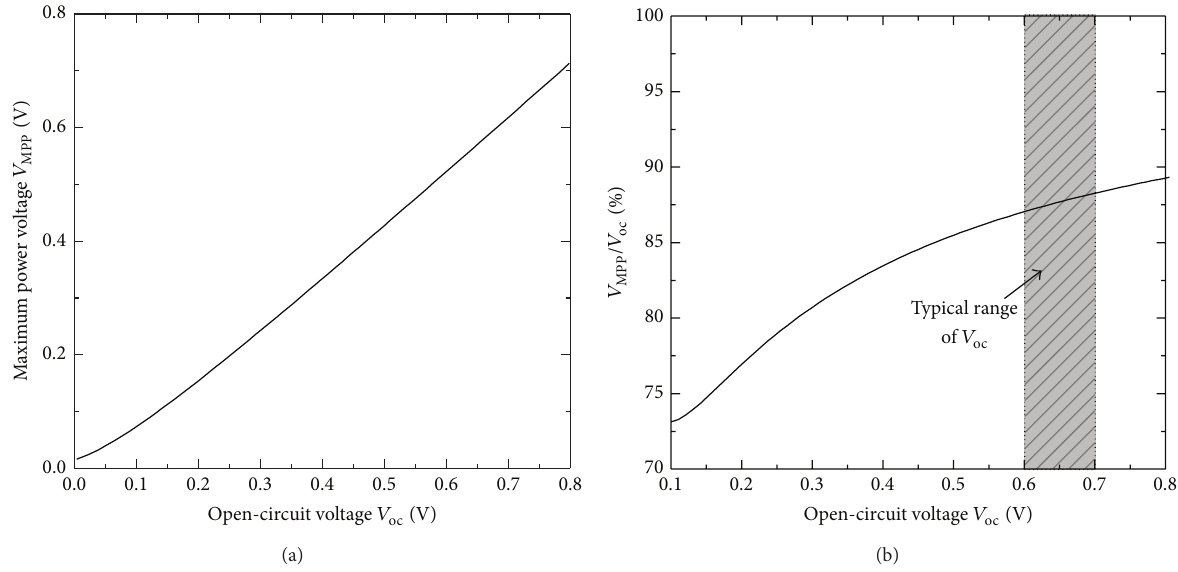
Figure 3: (a) MPP voltage against open-circuit voltage and (b) the percentage of 𝑉 typical 𝑉 oc